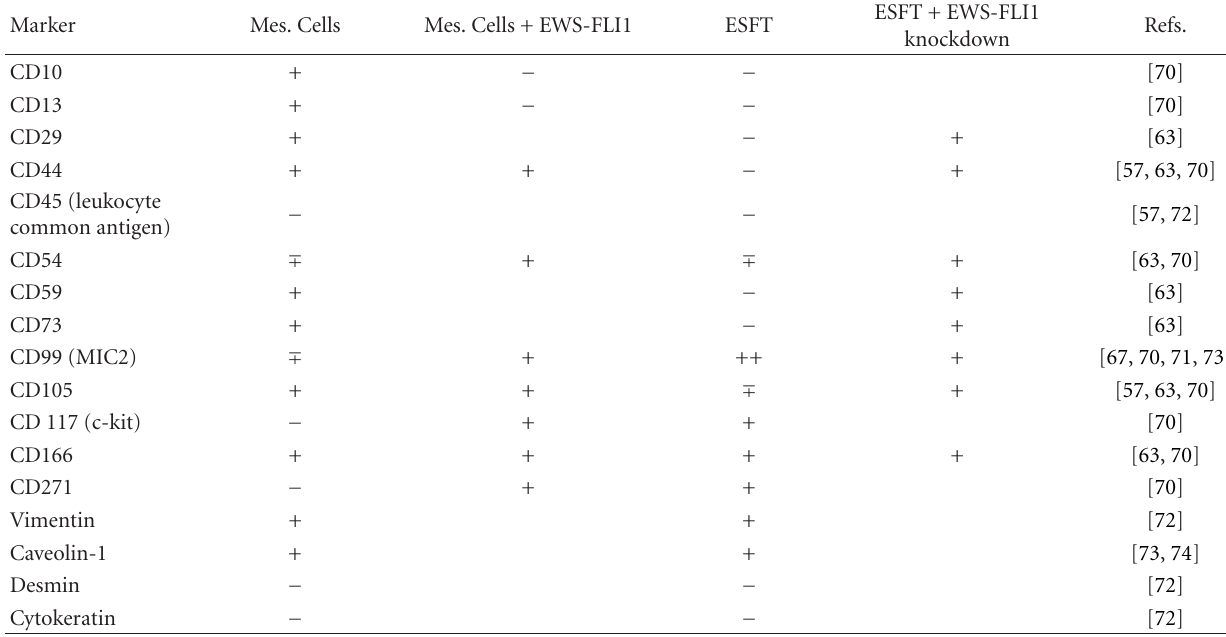
Table 1: Cell surface marker analysis of mesenchymal cells and Ewing’s sarcoma.